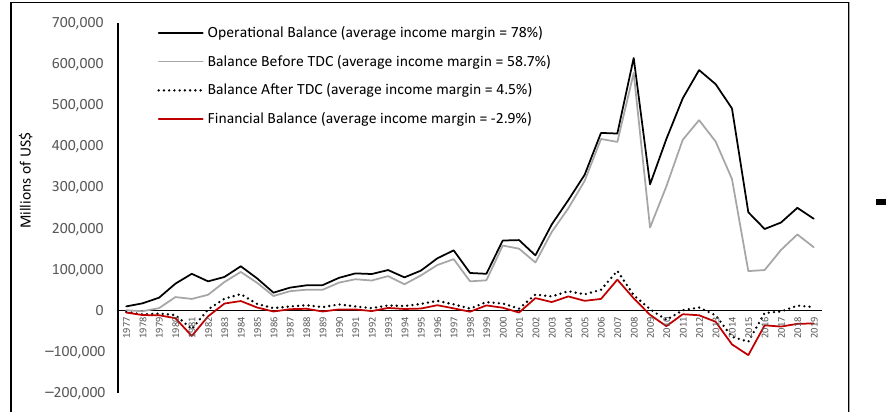
Figure 4. Pemex ’ s